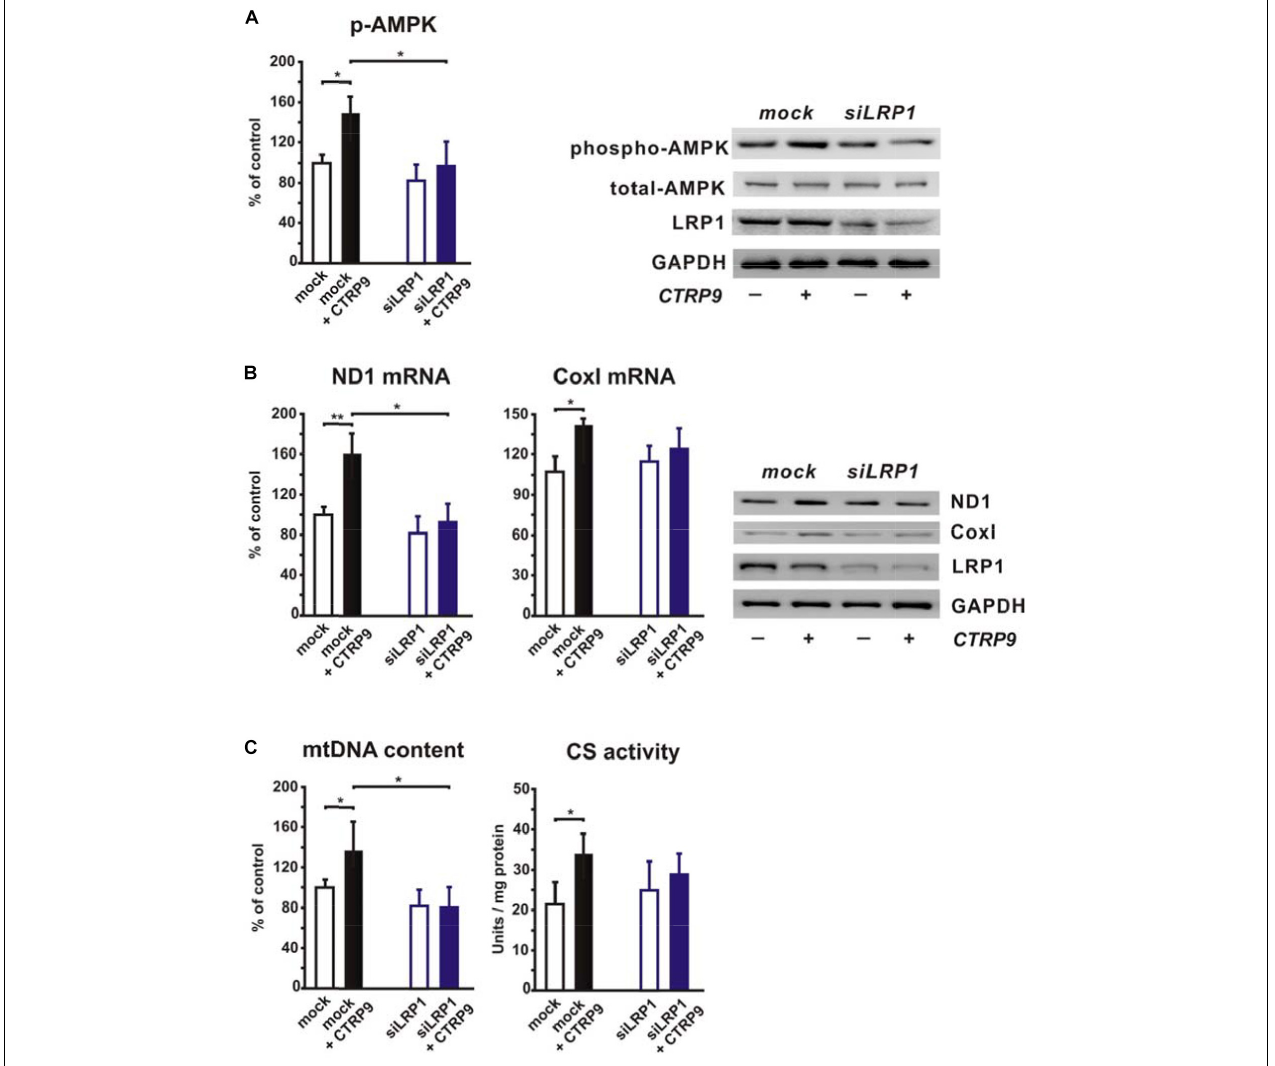
FIGURE 1 | Impact of LRP1 on CTRP9-induced mitochondrial biogenesis. H9C2 cardiomyoblasts were transfected with siRNA directed against rat LRP1 or mock siRNA for 48 h and subsequently treated with CTRP9 (4 µ g/ml) for the indicated times. (A) Cells were treated with CTRP9 (4 µ g/ml) for 20 min and afterward analyzed by Western Blotting for p-AMPK, total-AMPK and LRP1. Representative Western blots and densitometry of protein data are shown. GAPDH served as a loading control. (B) Cells were treated with CTRP9 (4 µ g/ml) for 24 h. mRNA expression of ND1 and Cox I as determined by real-time PCR (left panels) and representative Western blots for ND1, Cox I, LRP1, and GAPDH (right panel) are shown. (C) Cells were treated with CTRP9 (4 µ g/ml) for 24 h. Genomic DNA was isolated from the cells and afterward analyzed by Real-time PCR for the expression of a mitochondrial transcript and a nuclear transcript in order to estimate mtDNA content (left panel). Citrate synthase (CS) activity (right panel) was measured in H9C2 cell lysates. All values were normalized to total protein content of the respective sample. All data are mean ± SEM, 4 independent experiments, n = 8 per group, * p < 0.05, ** p <